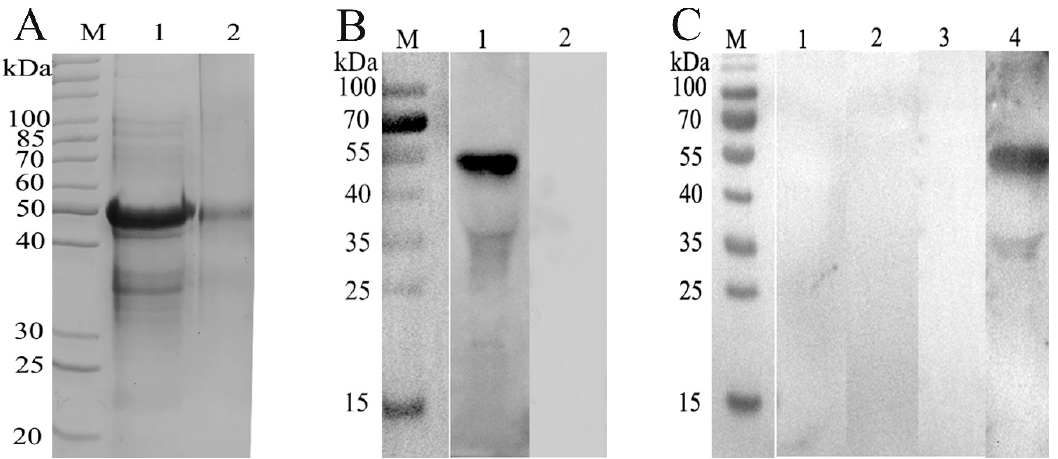
Figure 1. ( A) SDS-PAGE. Lane M: Standard protein molecular weight marker; lane 1: rHcRas (recombinant H. contortus Ras domain-containing protein) was expressed after induction with IPTG (isopropyl β -D-1-thiogalactopyranoside); lane 2: purified rHcRas. ( B ) Western blot. Lane 1: rHcRas was recognized by sera from goats infected with H. contortus ; lane 2: no reactions between rHcRas and normal goat serum (negative control). ( C ) Western blot to evaluate the specificity of rHcRas. Lane 1: no reaction with antibody against F. hepatica ; lane 2: no reaction with antibody against T. gondii ; lane 3: no reaction with antibody against T. spiralis ; lane 4: positive reaction with antibody against H. contortus (positive control).